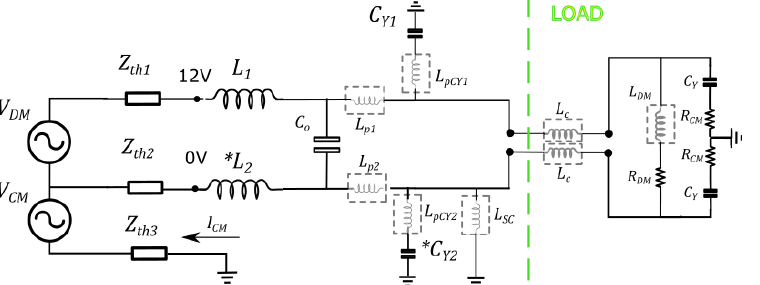
Figure 2. Equivalent model of the converter at the output. In ‘S’ configurations: L 1 = L /2, L 2 = L /2. In ‘AS’ configurations: L 1 = L , L 2 = 0. In ‘CC’ configurations: C Y 1 = C Y and C Y 2 = C Y . In ‘C0VG’ configurations: C Y 1 = C Y and C Y 2 is a short circuit. Asterisks in L 2 and C Y 2 indicate that these components might not be present depending on the filter